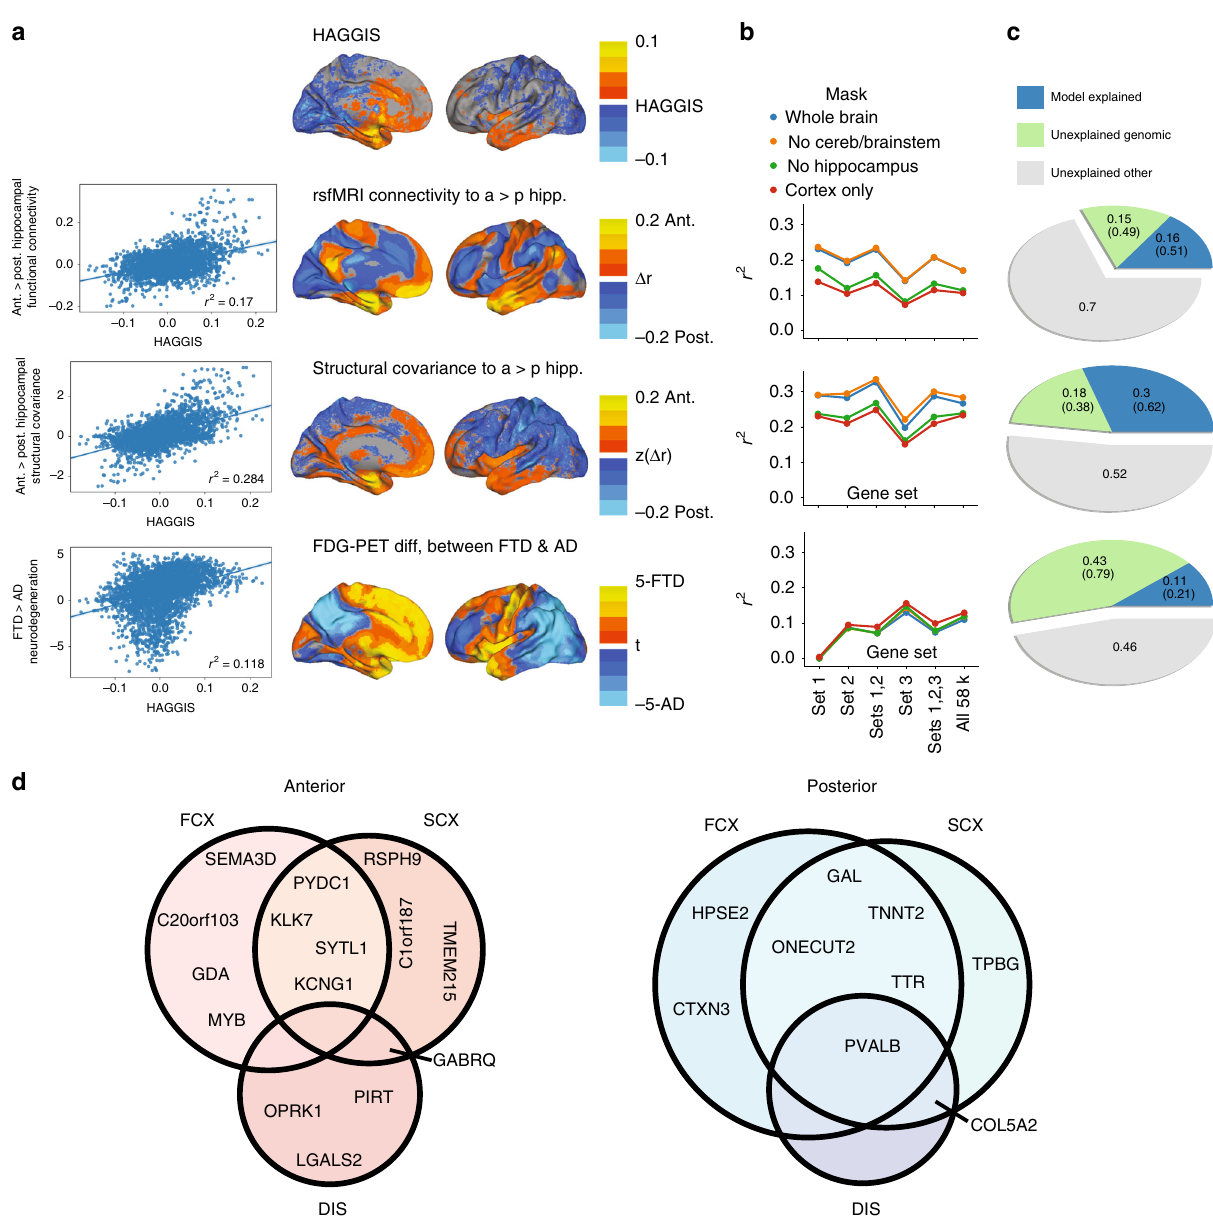
Fig. 5 HAGGIS predicts hippocampus – brain relationships. a From top to bottom: The spatial distribution of (smoothed) HAGGIS across samples, differential functional connectivity to the anterior vs. posterior hippocampus measured with rsfMRI, differential structural covariance with the anterior vs. posterior hippocampus, differential vulnerability to AD or FTD measured with FDG-PET. Graphs on the left visualize the relationship between these spatial patterns by comparing the HAGGIS of each sample with the mean value from the respective map within a 5-voxel cube around the sample coordinate. b Each of the above associations was re-calculated using three other brain masks, and using a HAGGIS formed from each gene set identi fi ed in the section (genes associated with the long axis of the human hippocampus in Results). The r 2 of each of these associations is visualized. c Pie charts indicating the proportion of genomic and total variance explained by each model. Numbers in parentheses indicate percentage of total genomic variance. d Genes involved in both the longitudinal axis of the hippocampus, and hippocampus – brain interactions. All genes pictured are among the top 50 anterior (red; left) or posterior (blue; right) features of the hippocampus longitudinal axis model. Each also participates in one or more hippocampus – brain interactions, indicated by the circles within the Venn diagrams. FCX Differential functional connectivity between anterior and posterior hippocampus; SCX Differential structural covariance between anterior and posterior hippocampus; DIS Differential vulnerability between AD and